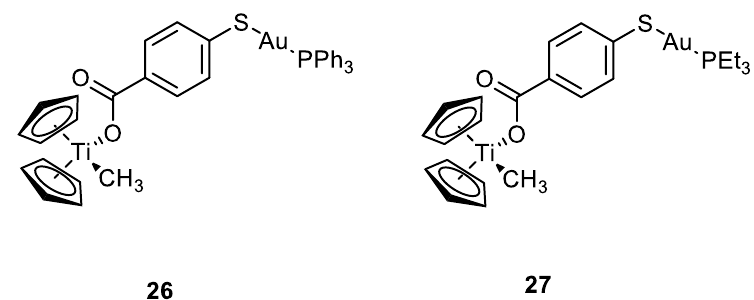
Figure 14. Molecular structure of compounds 26 and 27 .